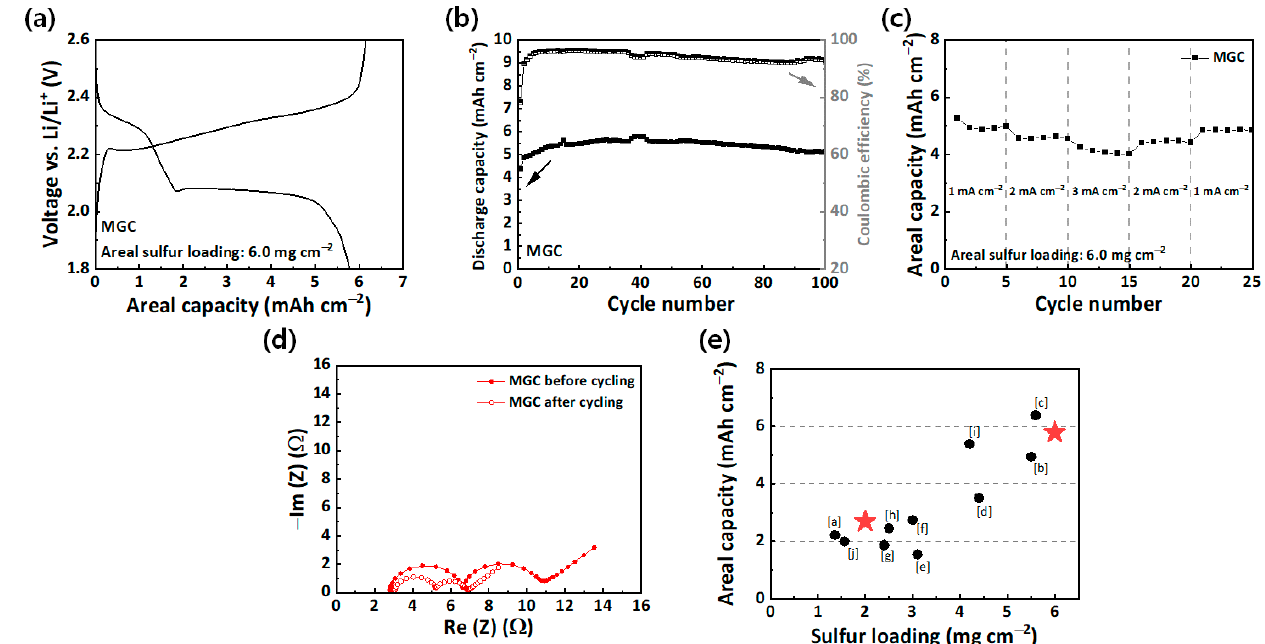
Figure 5. ( a ) GCPL profile of MGC under sulfur loading 6.0 mg cm − 2 at 1 mA cm − 2 and 39 th cycle, ( b ) cycle stability, ( c ) rate capability, ( d ) EIS spectra, and ( e ) areal capacity vs. sulfur loading Ragone plot. Table 4. EIS fitting results of MGC using a CPE model under sulfur loading 6.0 mg cm − 2 . Cell